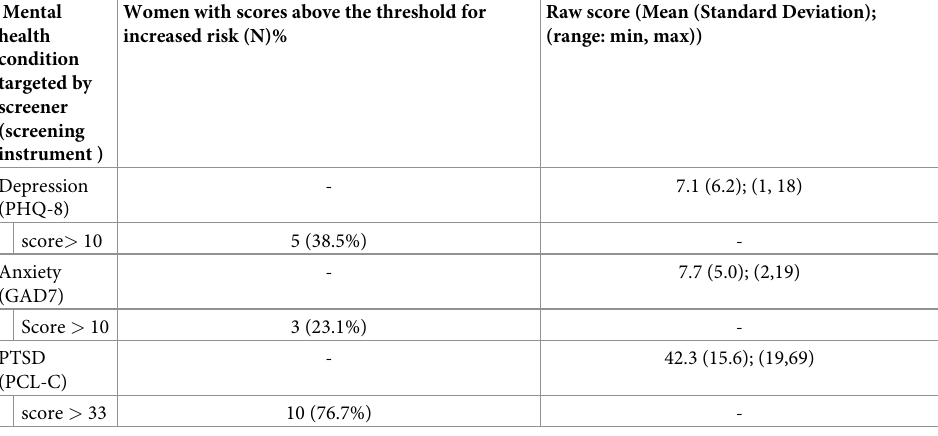
five out of thirteen participants had scores above the threshold for depression (PHQ-8 score > 10), three out of thirteen for generalized anxiety (GAD-7 score > 10), and ten out of thirteen for PTSD (PCL-C score > 33). The four participants that scored below 33 reported mild symp- toms (range = 19–28). Although we lacked the statistical power to compare mental health Table 3. Distribution of scores on mental health screeners for risk of depression, anxiety, post-traumatic stress disorder. Mental Women with scores above the threshold for health increased risk